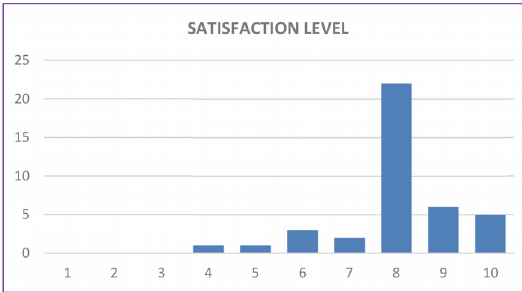
Figure 7. Degree of student satisfaction regarding teaching innovation. Own